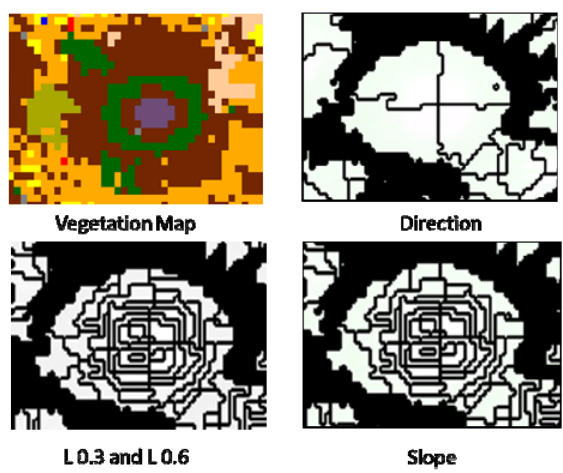
Figure 6. Segmentation of the mountain area of Mt. Yotei in Hokkaido Figure 5 shows Asahikawa City of Hokkaido in